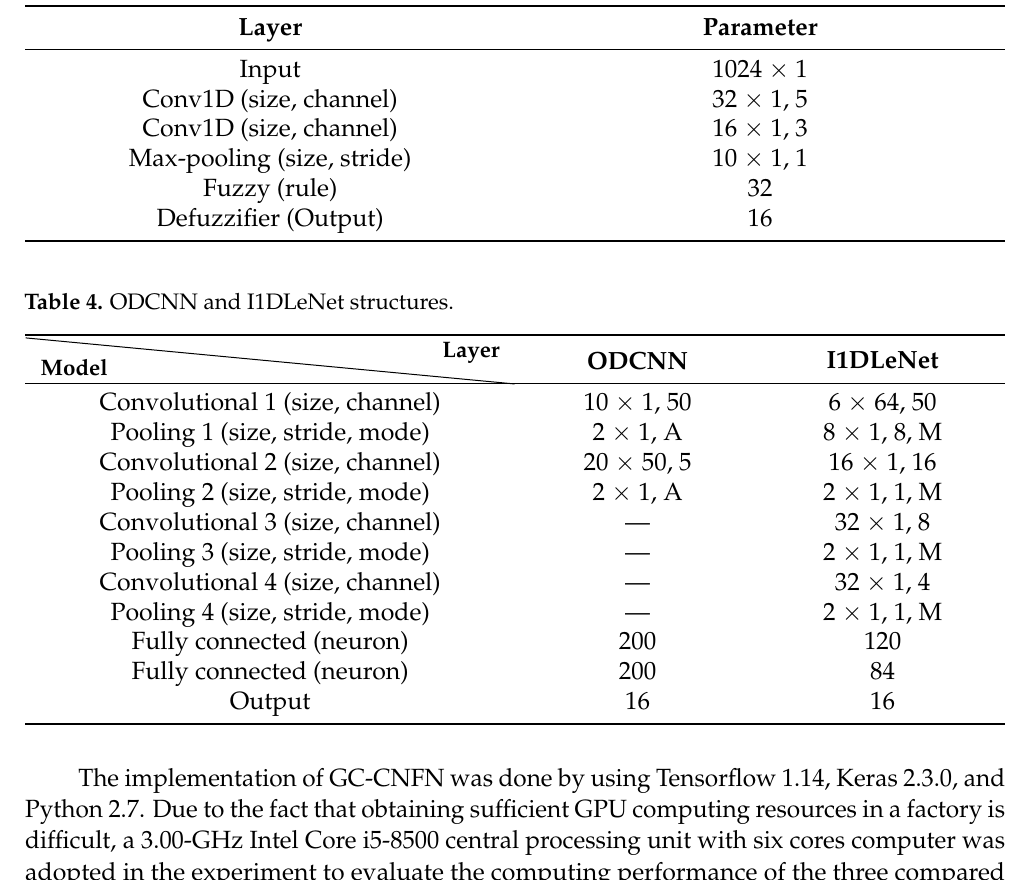
Table 3. Architecture of the GC-CNFN.